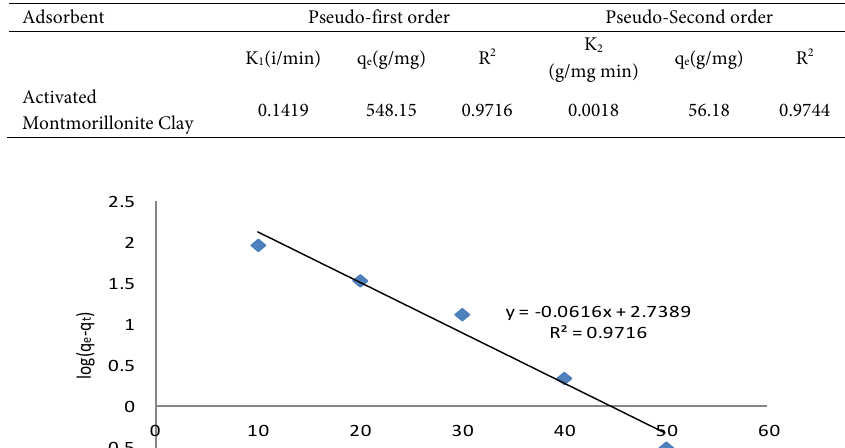
Fig. 5. Pseudo-first order kinetic plot